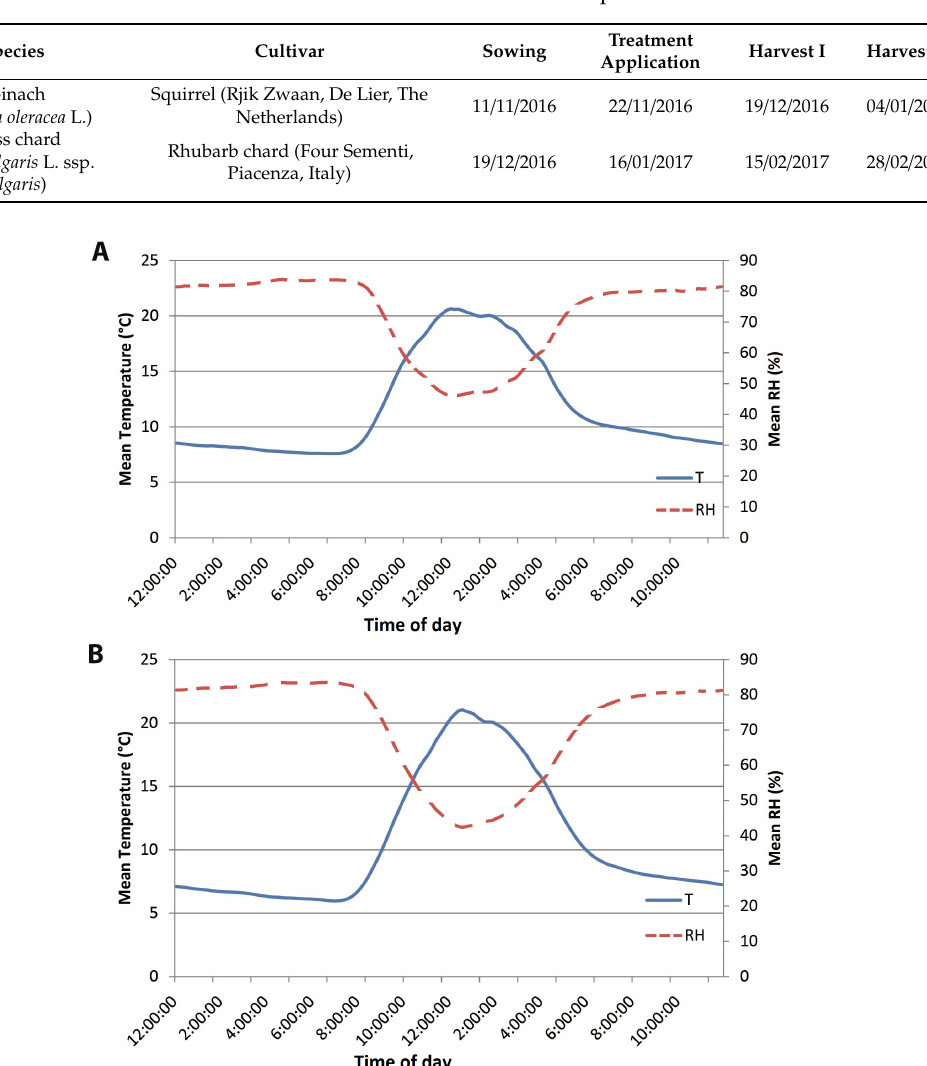
Table 1. Plant materials and dates of the experiment.